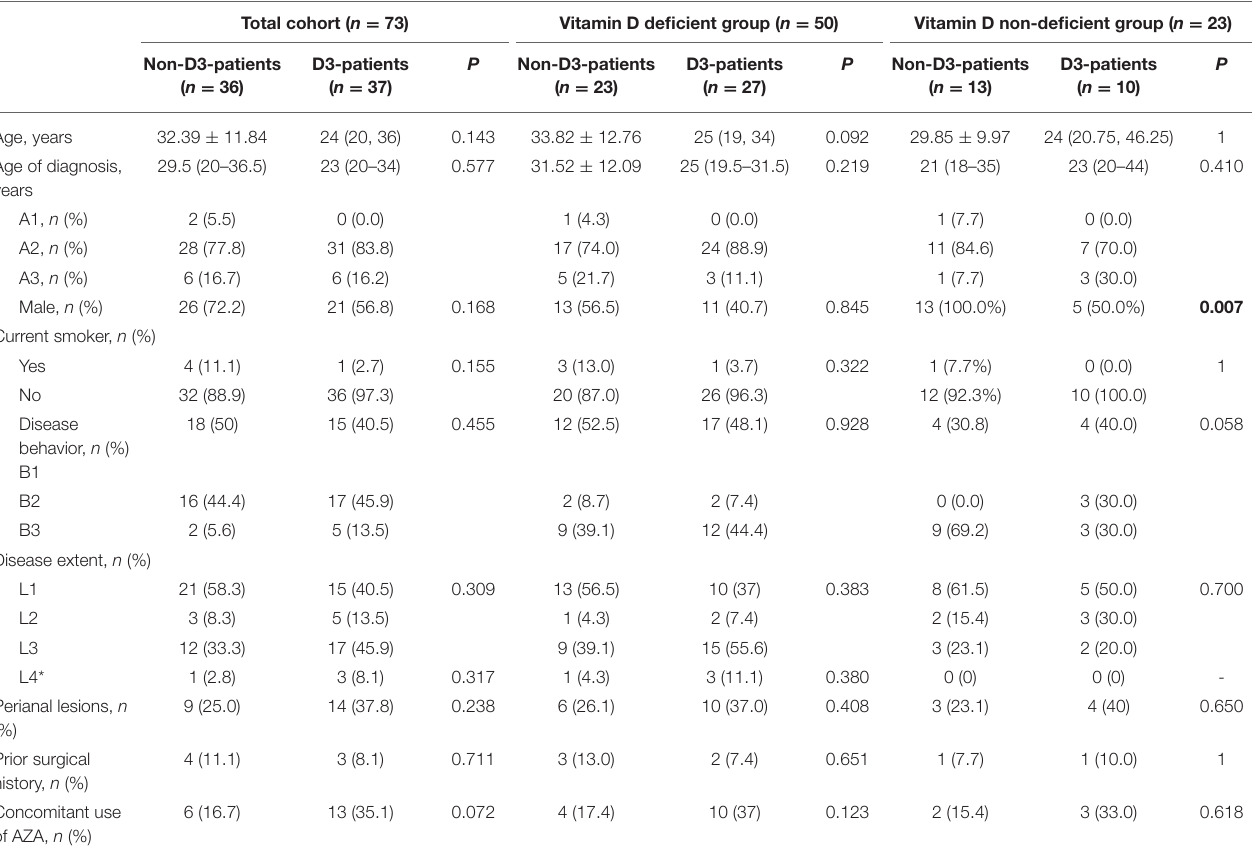
TABLE 1 | Baseline